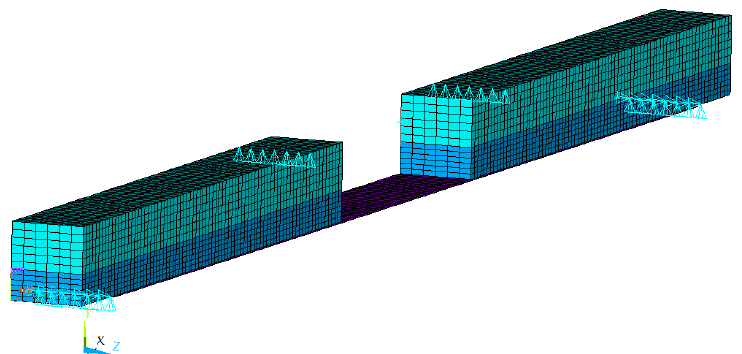
Figure 4. FEM model of a beam reinforced with CFRP (a section is removed for illustration